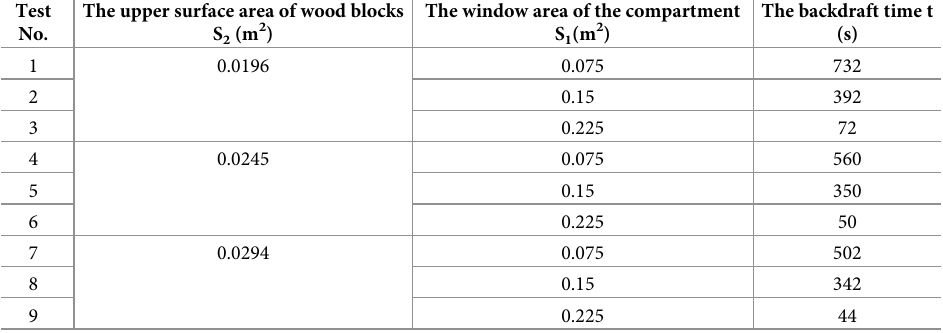
Table 1. Experimental settings. Test The upper surface area of wood blocks No. S 2 (m 2 )